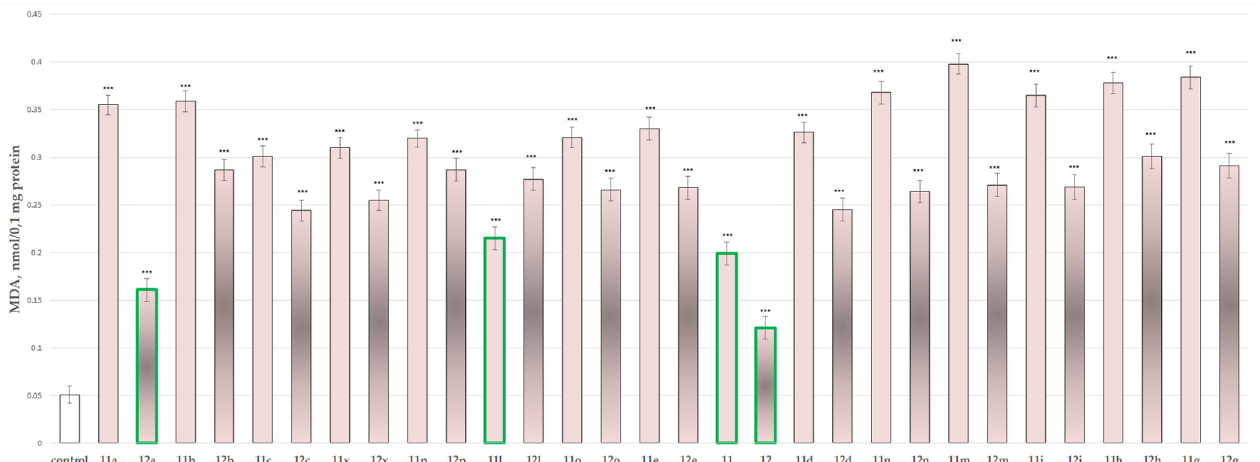
Figure 7. Effects of compounds 11 , 11a – 11x, 12 and 12a – 12x (100 μ mol), applied alone, on the GSH levels. * p < 0.05; ** p < 0.01 against the control (untreated mitochondria). The green outline indicates the most promising derivatives. On MDA production, administered alone, most of the substances showed prominent neurotoxicity, except for substances 11, 12, 11l , and 12a which showed weak toxicity ele ‐ vating the MDA production by 290%, 137%, 320% and 216%, respectively. On the other evaluated parameter (GSH level), 12 did not perform any statistically significant neurotoxic effect. Compounds 11 , 11l and 12a decreased the GSH production by 20%, 30% and 20%, respectively, against the control (untreated mitochondria). 2.2.4. Effects of the Tested Compounds 11 , 11a – 11x, 12 and 12a ‐ 12x on the Isolated Rat Brain Microsomes When tested alone in a concentration of 100 μ mol, the evaluated N ‐ pyrrolyl hydra ‐ zide–hydrazones performed pronounced toxicity on isolated rat brain microsomes, except for compounds 11 , 12 , 11l and 12a , which showed the lowest neurotoxicity, when com ‐ pared to the control (untreated microsomes) (Figure 8). 0 5 10